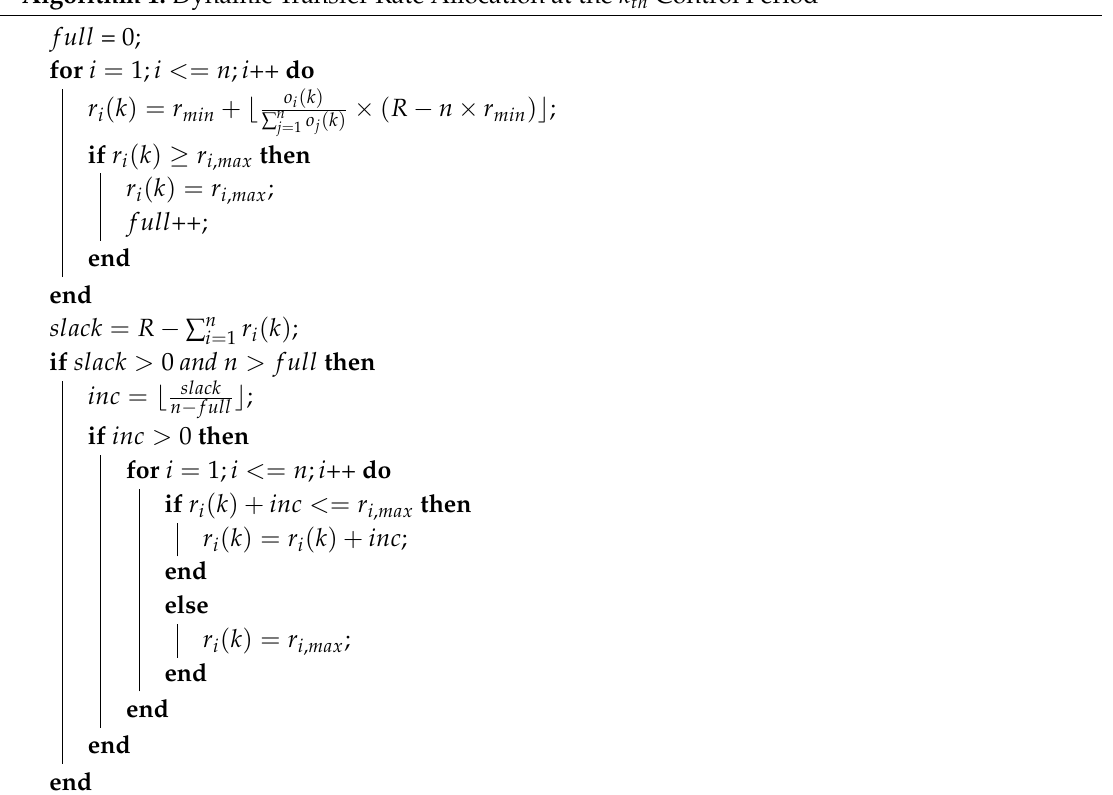
Algorithm 1: Dynamic Transfer Rate Allocation at the k th Control